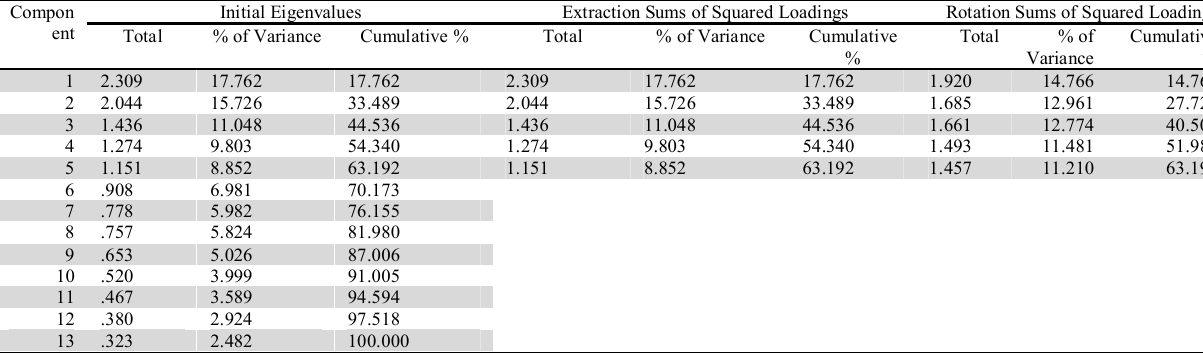
The summary of principal component